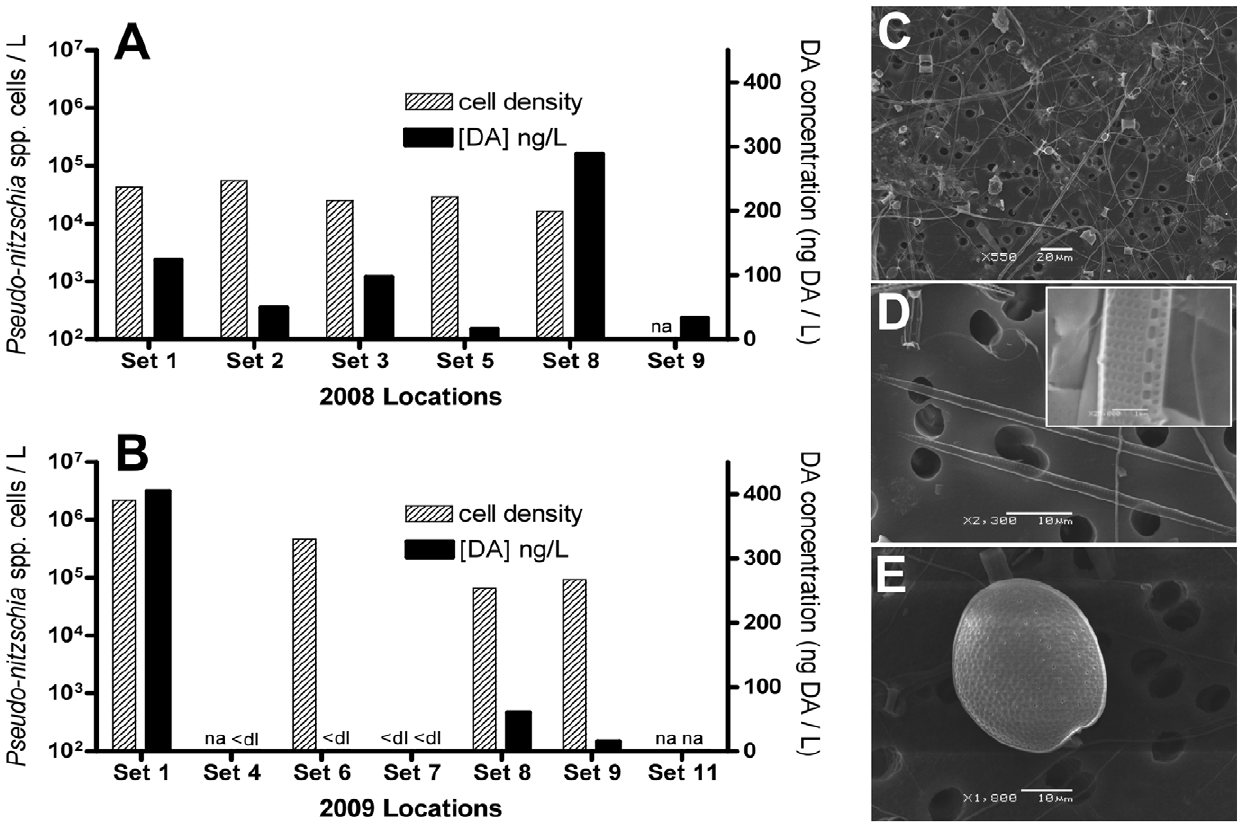
Figure 3. Pseudo-nitzschia spp. and domoic acid in Sarasota Bay, Florida, USA. Cell densities of Pseudo-nitzschia spp. and domoic acid water concentrations for various (A) 2008 and (B) 2009 set site locations. Scanning electron micrographs of three samples illustrating the presence of potential HAB species: C) A mixed assemblage of phytoplankton cells including Chatocerous spp. and Pseudo-nitzschia spp. from 2008 set site 8, D) P. pseudodelicatissima cells from 2008 sets sites 2, 5, and 8, and E) Prorocentrum compressum from 2008 set site 2. Note: Presence of